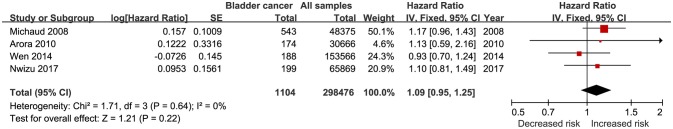
Forest plot of periodontal disease and risk of bladder cancer in overall population.